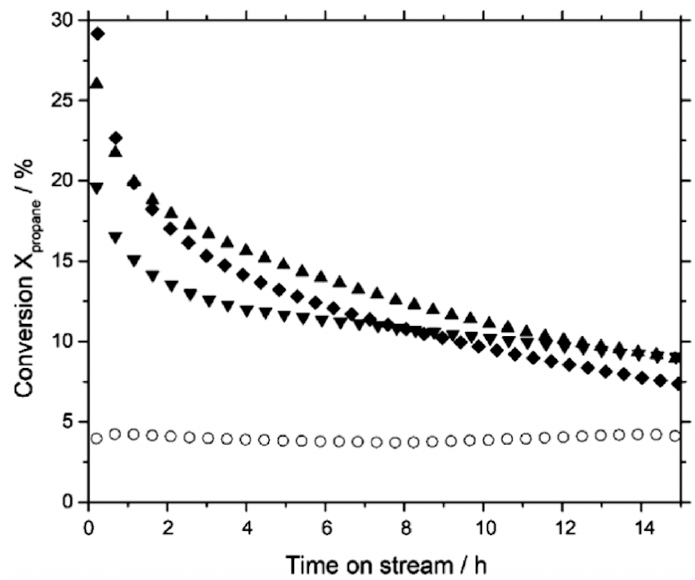
Figure 8. Propane conversion in PDH process over Ga-Rh catalyst (Reaction conditions: t = 550 ◦ C, P = 1.2 bar) with different Ga-Rh molar ratios: 0 = open circles, 34 = downward-pointing triangles, 89 = upward-pointing triangles, 125 = diamonds. (Reprinted with permission from [45]. Copyright 2019 American Chemical